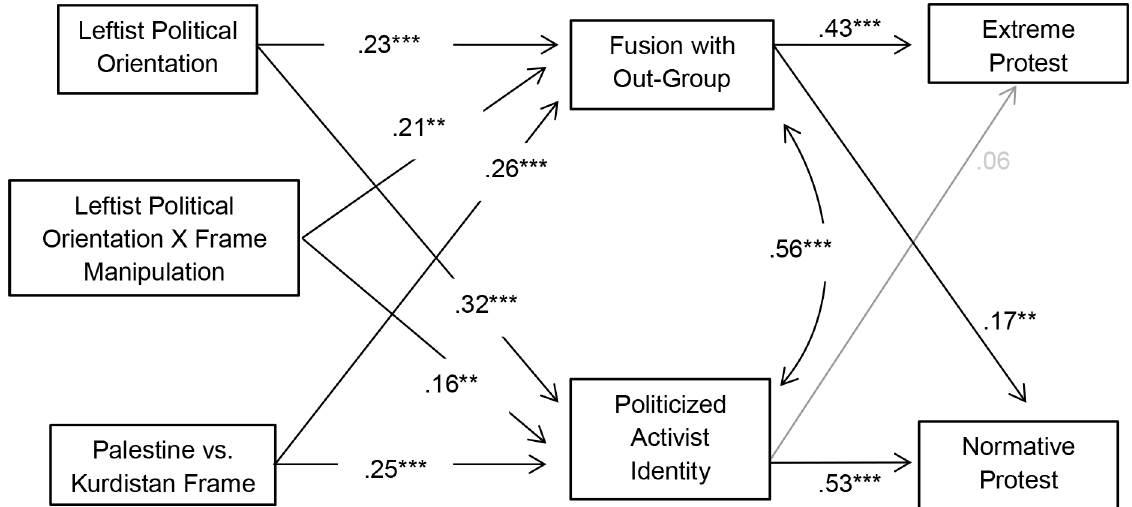
Fig 3. Moderated mediation model in Study 2 is displayed. * p < .05, ** p < .01, *** p < .001. Non-significant paths are displayedin grey.